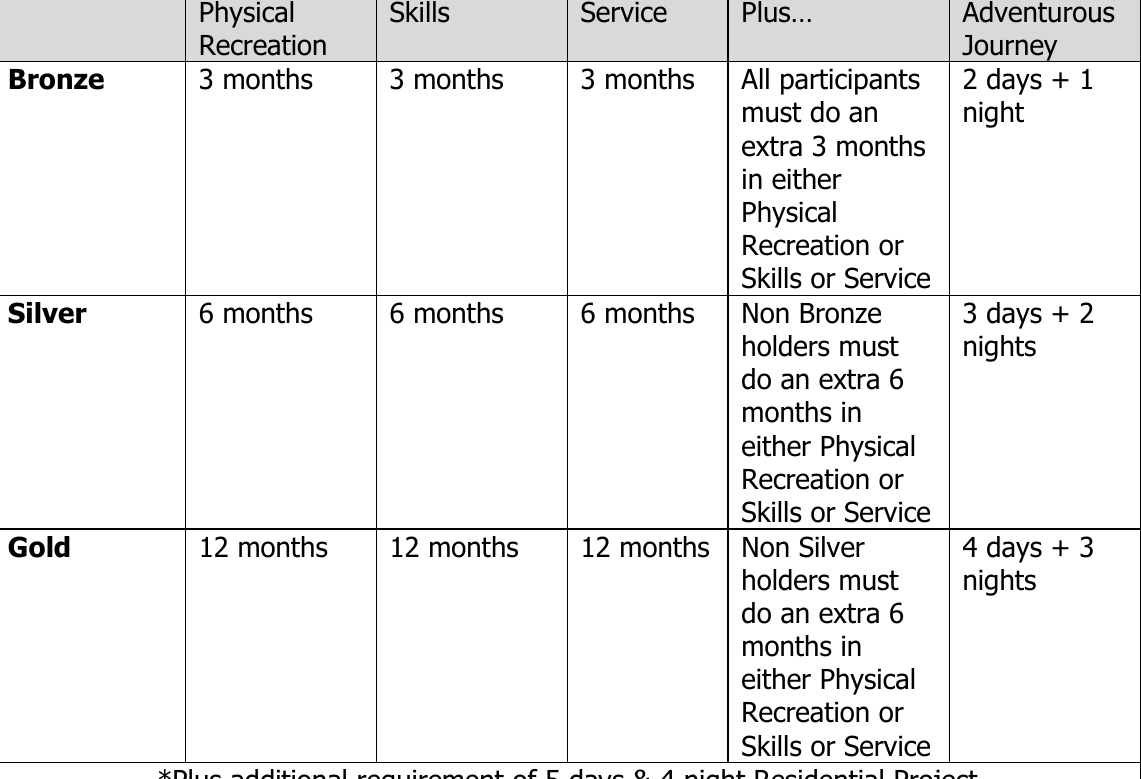
Minimum timescale for each level by section. Source: DofE handbook 6 th edition, 2012b,